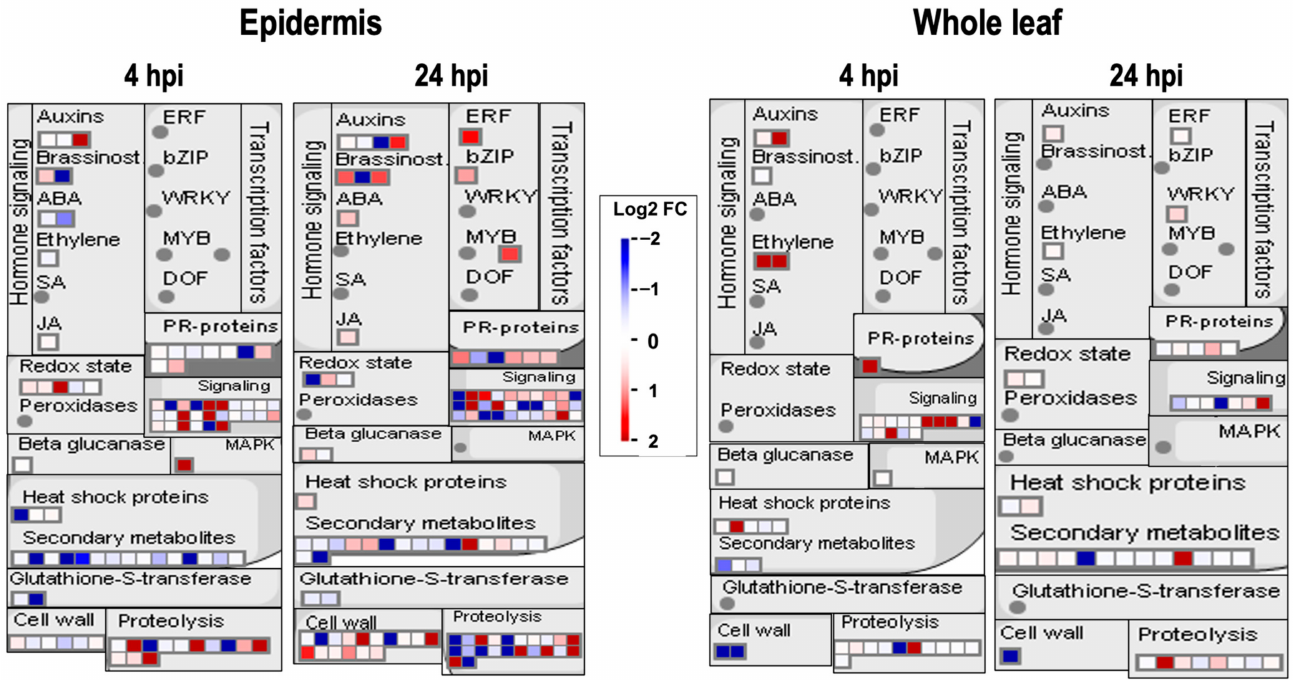
Figure 4. Mapping of proteins identified in the leaf epidermis and whole leaf, based on MapMan bin codes of the Isoform Model TAIR10 database (August 2012). Proteins identified in the leaf epidermis and whole leaf were listed with log2 FC values. Then, protein lists were mapped to the MapMan